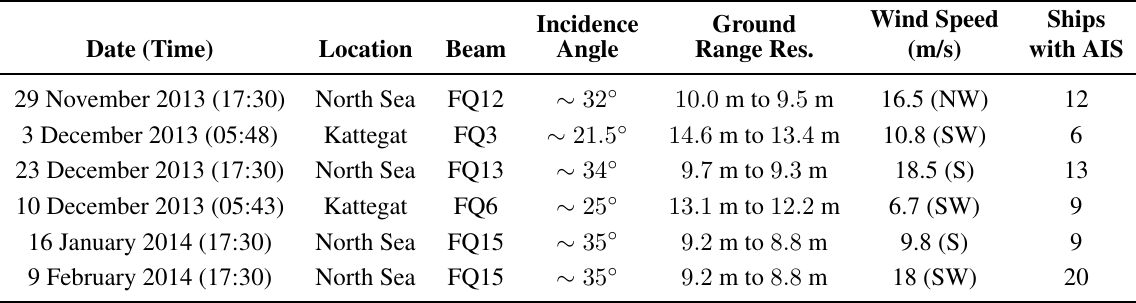
Figure 2. Locations (red polygons) of the six RADARSAT-2 fine quad-polacquisitions used in the comparison: Google Earth. Table 3. Details on fine quad-pol RADARSAT2 data. Time is in UTC. AIS, automatic identification